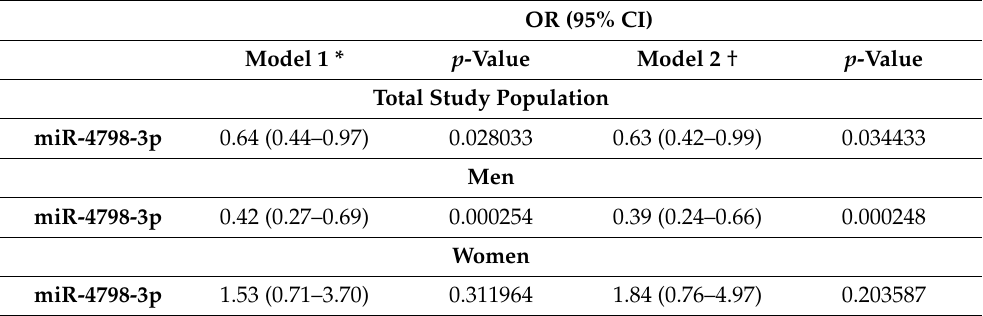
Table 2. Association between miR-4798-3p with the odds of prevalent atrial fibrillation in the total study population and stratified by sex.